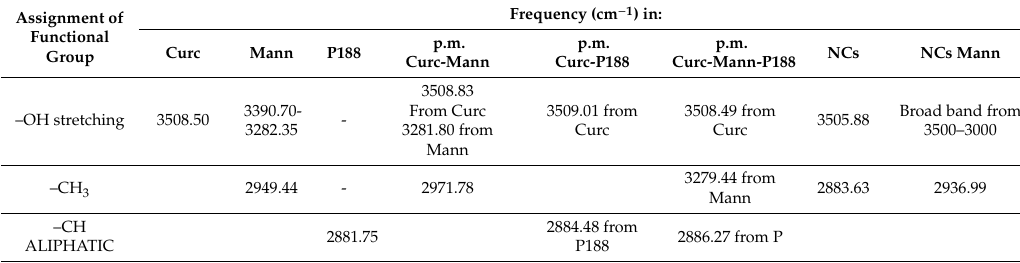
Table 5. Assignment of bands found in all sample spectra